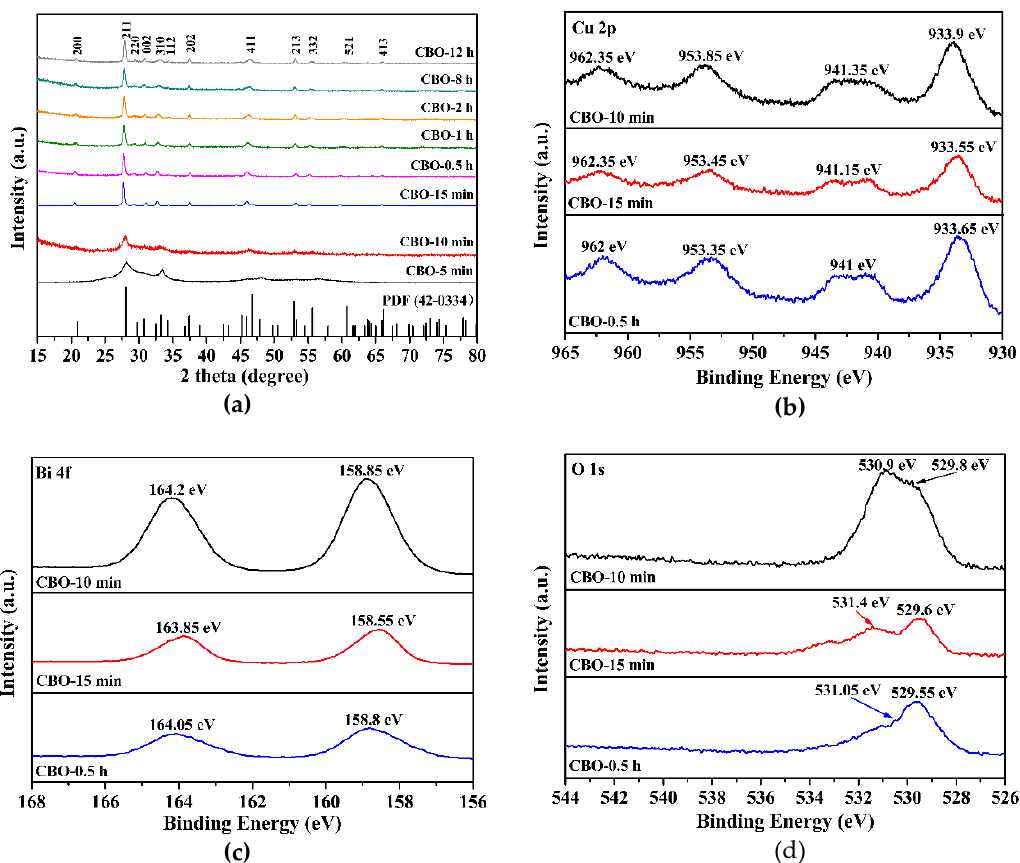
Figure 2. ( a ) XRD patterns of the CBO-5 min, CBO-10 min, CBO-15 min, CBO-0.5 h, CBO-1 h, CBO-2 h, CBO-8 h, CBO-12 h, and XPS high-resolution spectra of CBO-10 min, CBO-15 min, and CBO-0.5 h samples: ( b ) Cu 2p, ( c ) Bi 4f, and ( d ) O 1s.